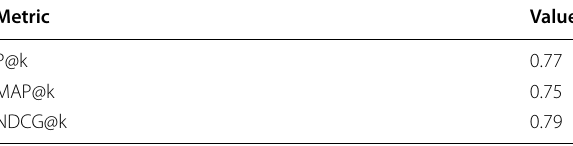
Table 6 Evaluation metrics of domain recommendation Table 7 Evaluation metrics of target